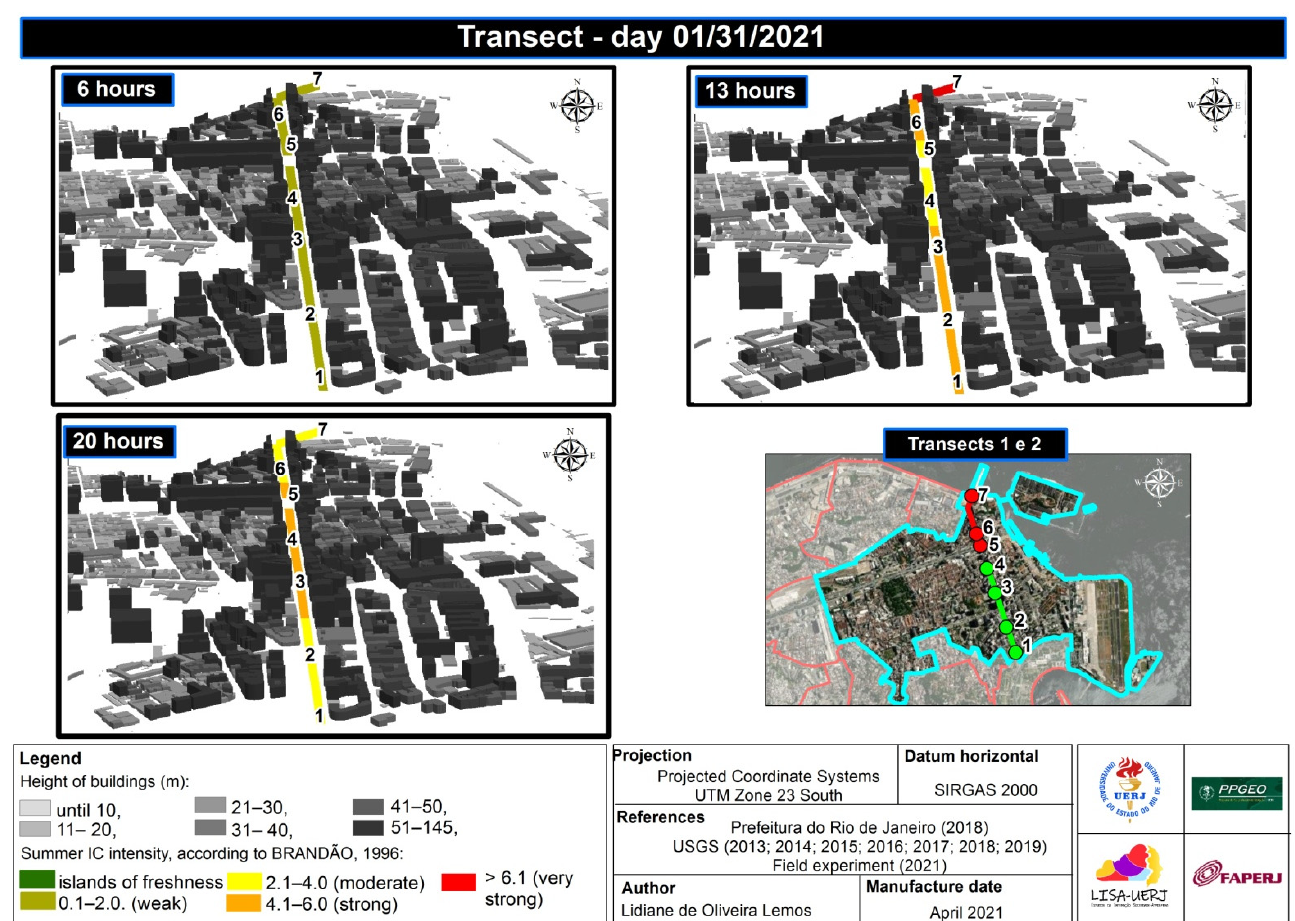
Figure 6. Rio de Janeiro-horizontal thermal field in the urban canyon of Avenida Rio Branco, 31 January (Sunday).